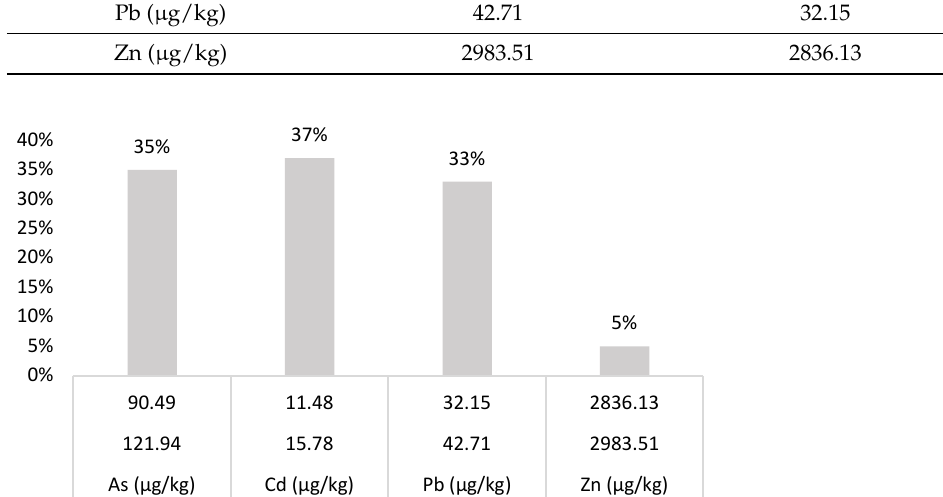
Figure 1. Difference between heavy metal concentrations in samples of fruit and vegetables washed with tap water and vinegar (5% acetic acid).